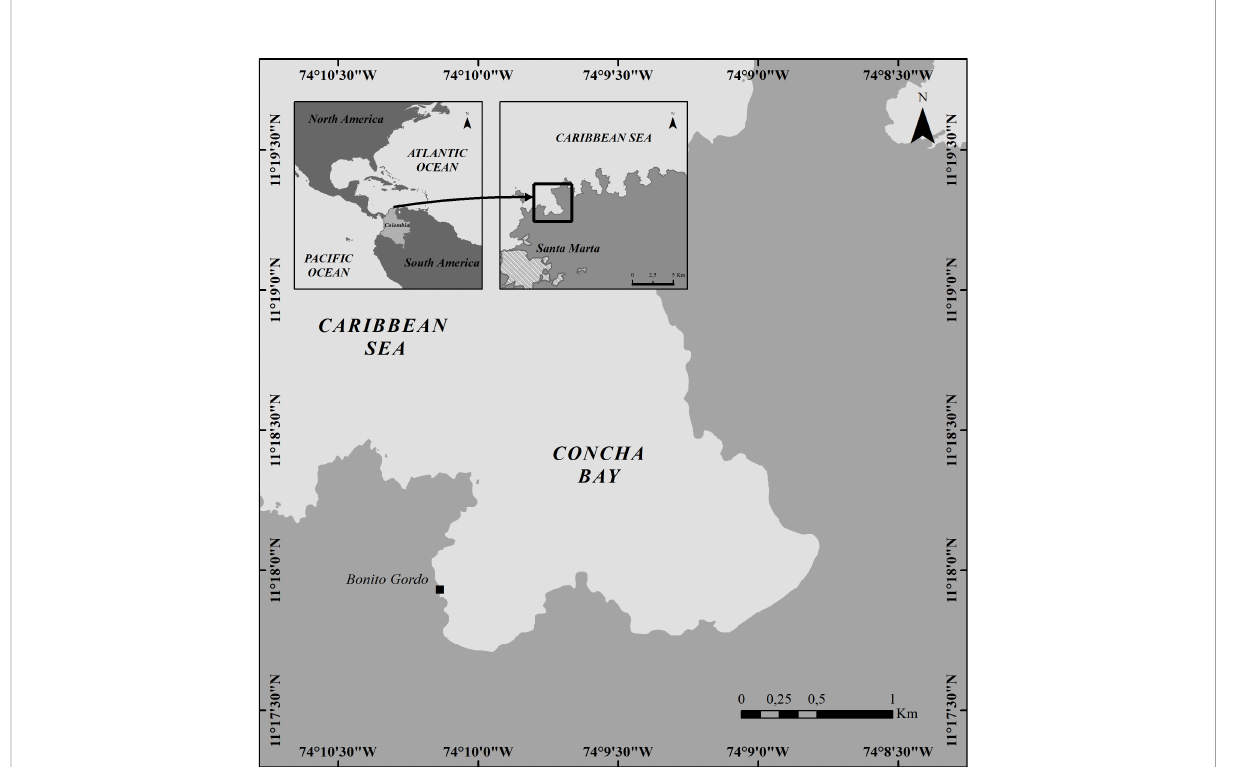
FIGURE 1 Sampling localization at Concha bay (Bonito Gordo), in the Tayrona National Natural Park (TNNP),